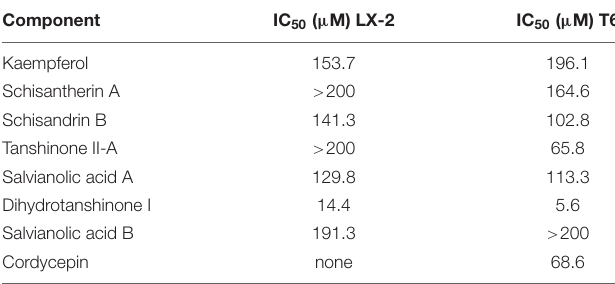
TABLE 2 | IC 50 values of active components with LX-2 and T6 cell